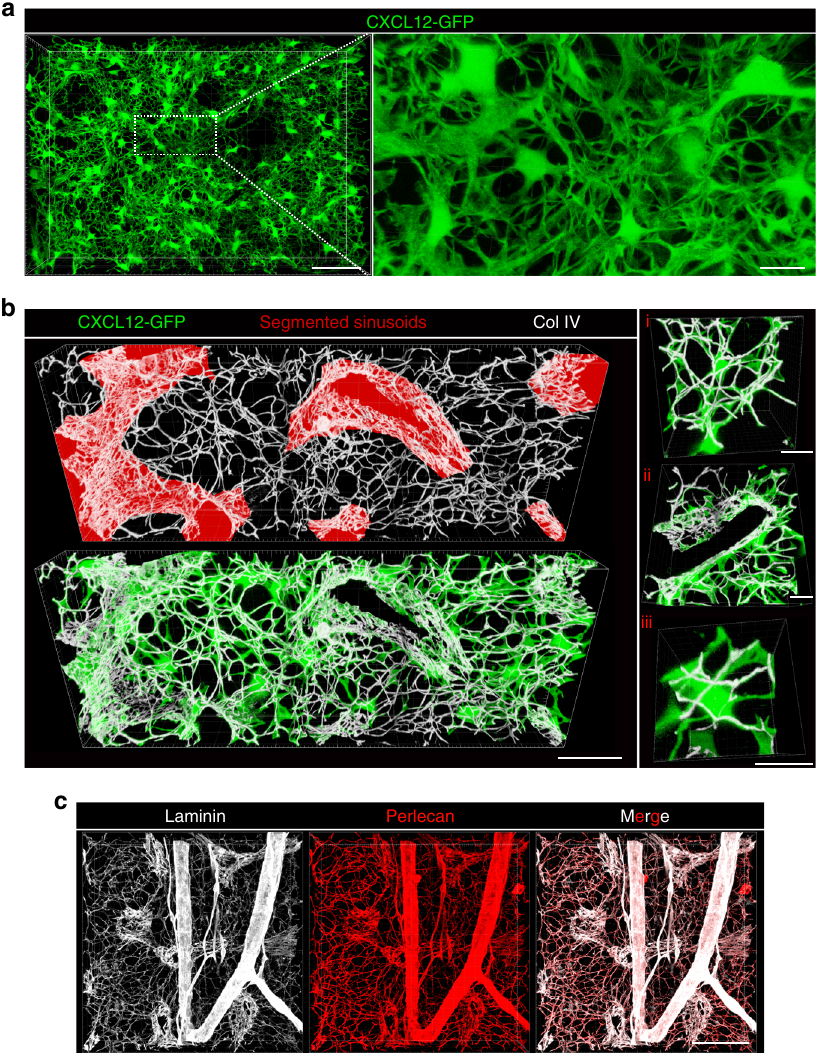
Fig. 4 CARcs assemble as dense pervasive networks associated to ECM fi bres. a 3D high-resolution reconstruction of CARc networks present in femoral BM cavities of Cxcl12-Gfp mice. Scale bar, 50 µ m. Details of the mesh of CARc cytoplasmic projections connecting the entire network are shown in the zoomed-in image on the right panel. Scale bar, 10 µ m. b 3D representative image of BM from Cxcl12-Gfp mice immunostained for ECM marker (collagen IV- Col IV white) and a sinusoidal marker (Endomucin red). Scale bar, 30 µ m. High-magni fi cation images of boxed regions are shown on the right